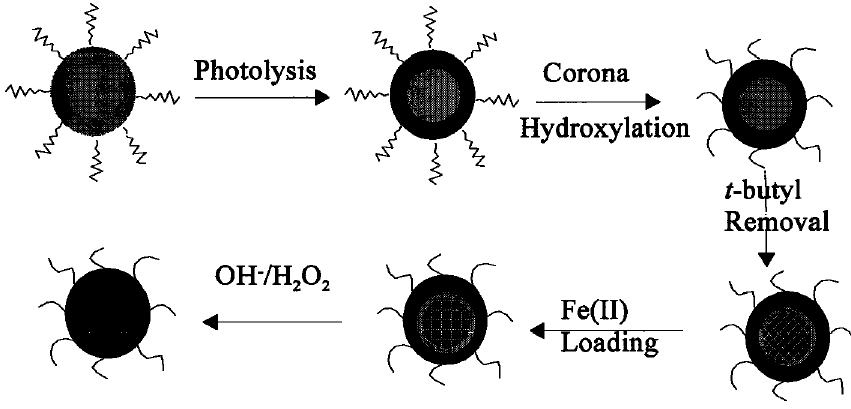
Figure 16. Polyisoprene- block -poly(2-cinnamoylethyl methacrylate)- block -poly( tert- butyl acrylate) (PI- b -PCEMA- b -P t BA) as template: Photolysis cross-links the PCEMA shell (gray to black); the PI corona chains are made water-soluble by hydroxylating the double bonds (wavy lines to free-hand lines); the core is made inorganic-compatible by removing the tert -butyl groups (light gray to gridded pattern). Soaking the nanospheres in aqueous leads to proton exchange (slanted to vertical grids) and the Fe 2+ ions are precipitated FeCl 2 (NaOH) and oxidized (H O ) to yield cubic γ-Fe O magnetic particles (last step). 2 2 2 3 Adapted with permission from [40]. Copyright 2000 American Chemical